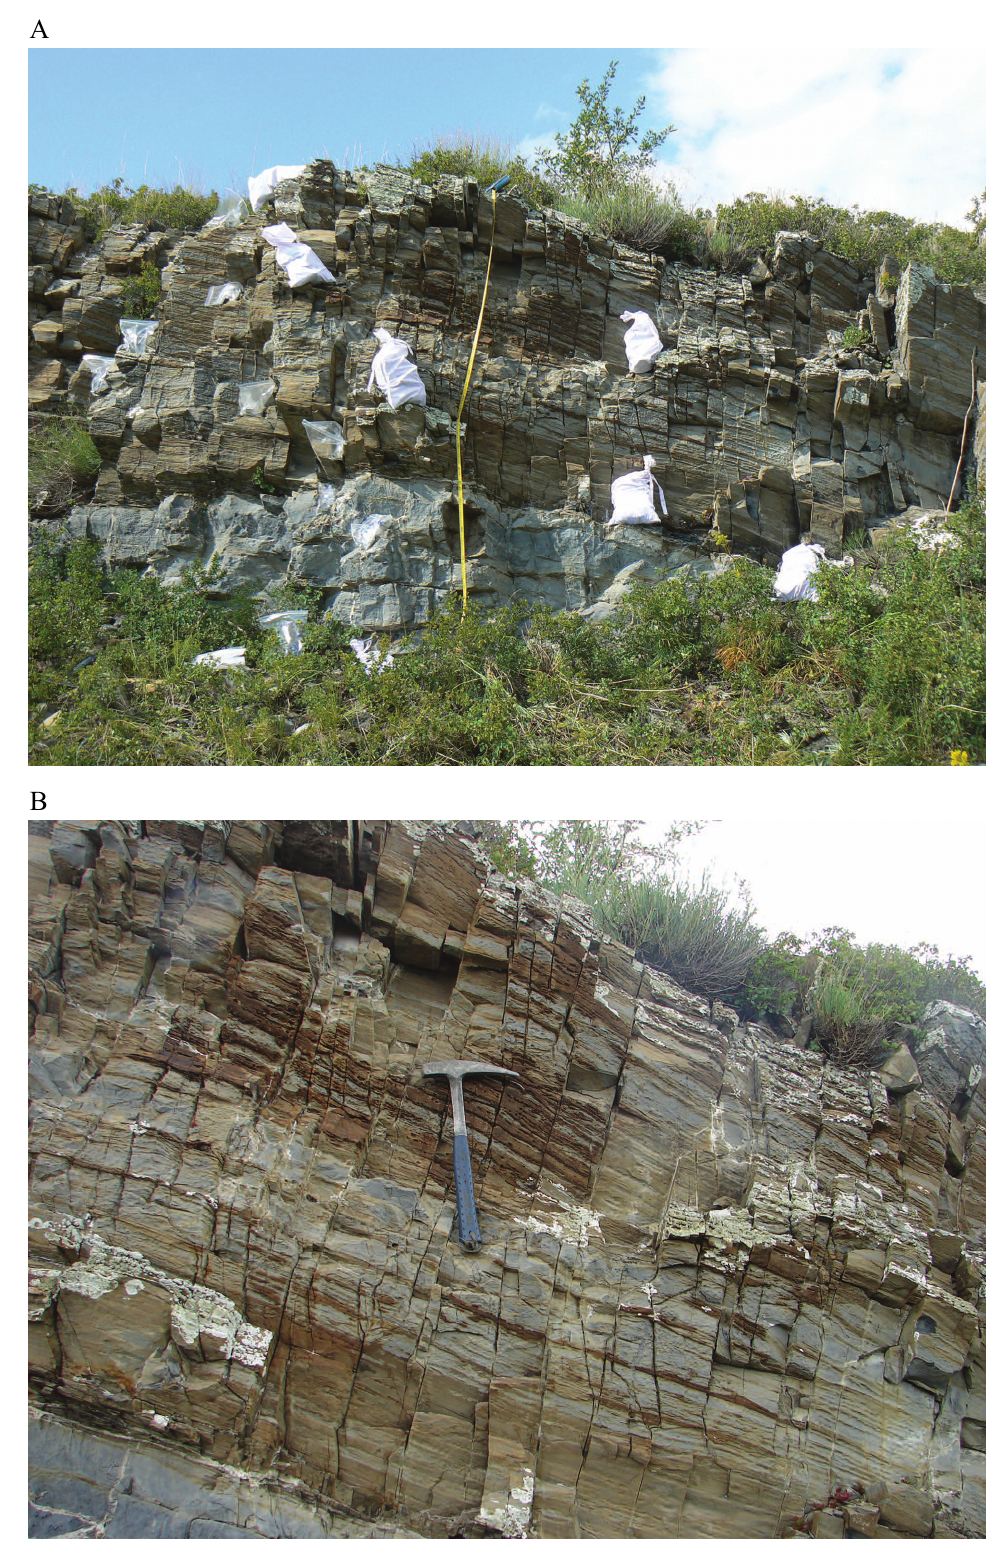
Fig. 2. A , the 3 m thick Dalmanitina Limestone Member in the Burovlyanka outcrop with the light grey lower unit and the dark grey (beige) upper unit. The ruler is 2.8 m long. B , upper part of the Dalmanitina Member with fine-bedded argillaceous lime- stone. The hammer is 30 cm long. Photos by N.